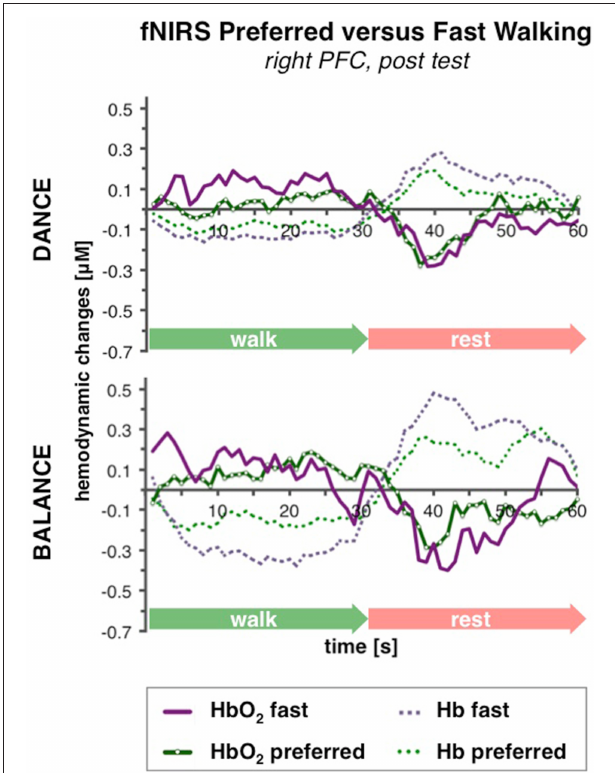
FIGURE 6 | Comparison of preferred vs. fast walking PFC activity. Graphs represent time-triggered group averages. Identical line color and style in Figures 4 – 6 represent the same data. Within the timeframes t1–7 and t10–25 HbO 2 levels were higher at fast compared to preferred walking speed in DANCE and BALANCE. PFC activity at pre-test was equal for preferred and fast walking speed (graphs not shown). DANCE, video game dance training; BALANCE, balance and stretching training, PFC, prefrontal